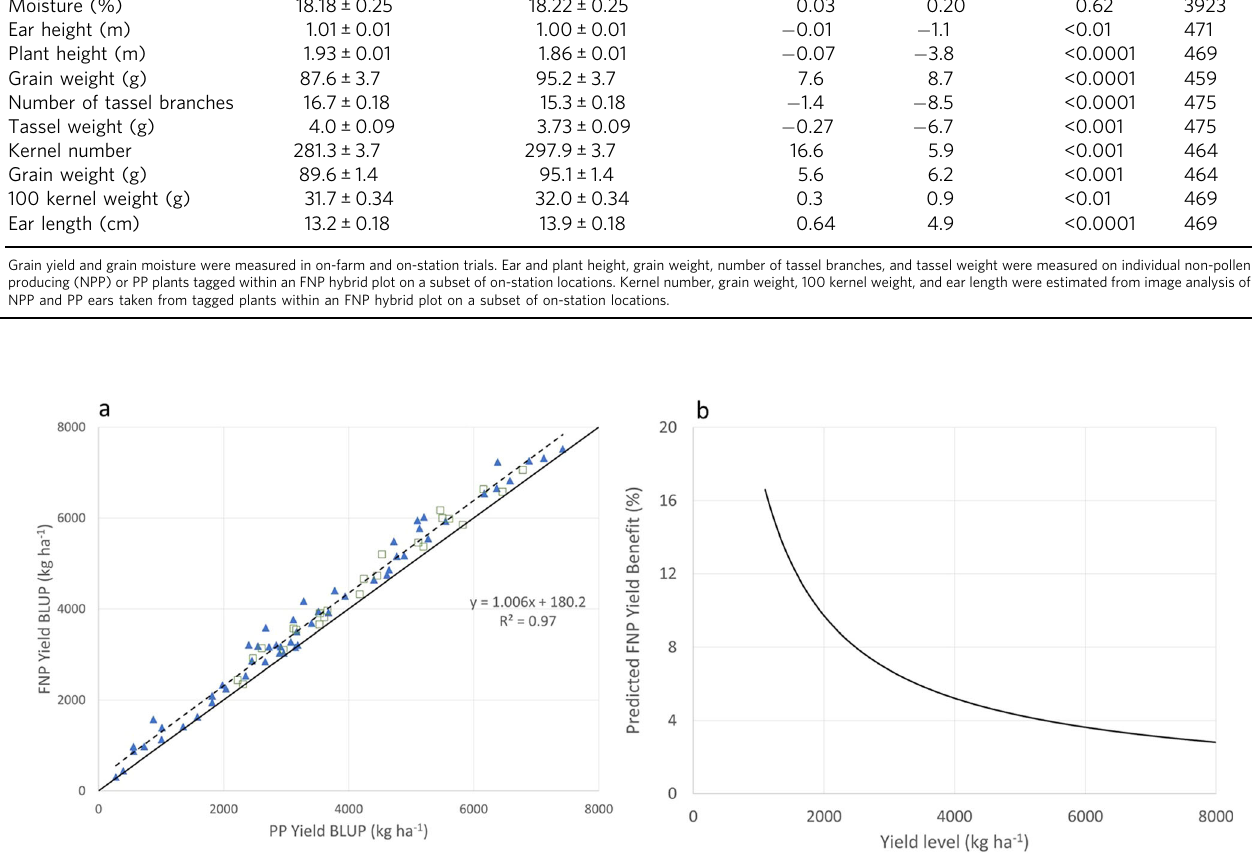
Fig. 1 Yield bene fi t of 50% non-pollen producing (FNP) hybrids over conventional (PP) hybrids. Yield (kg ha − 1 ) of 50% non-pollen producing (FNP) hybrids compared with conventional PP hybrids grown across multiple locations and years as shown in Supplementary Table 1 and Supplementary Fig. 1. a FNP hybrids yield (kg ha − 1 ) ( y -axis) plotted against the yield of pollen-producing (PP) conventional hybrids ( x -axis). Each point represents the mean of four to nine hybrid backgrounds for on-farm trials (OFT) (blue diamond) and 4 – 15 hybrid backgrounds for on-station trial (OST) (yellow square). The solid black line represents the 1:1 relationship and the fi tted regression line is shown (blue dotted). b Percent yield increase predicted by growing FNP hybrids ( y - axis) plotted against location mean yield ( x -axis). Yield increase was projected using the fi tted linear regression in a to predict the yield of